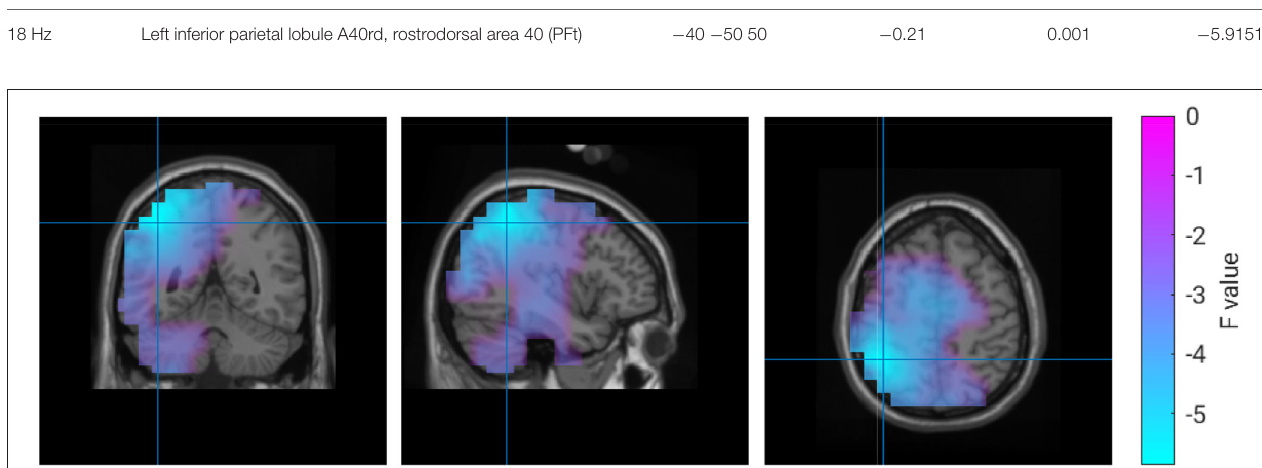
TABLE 3 | Clusters of brain activity correlating with tracking error. Freq.